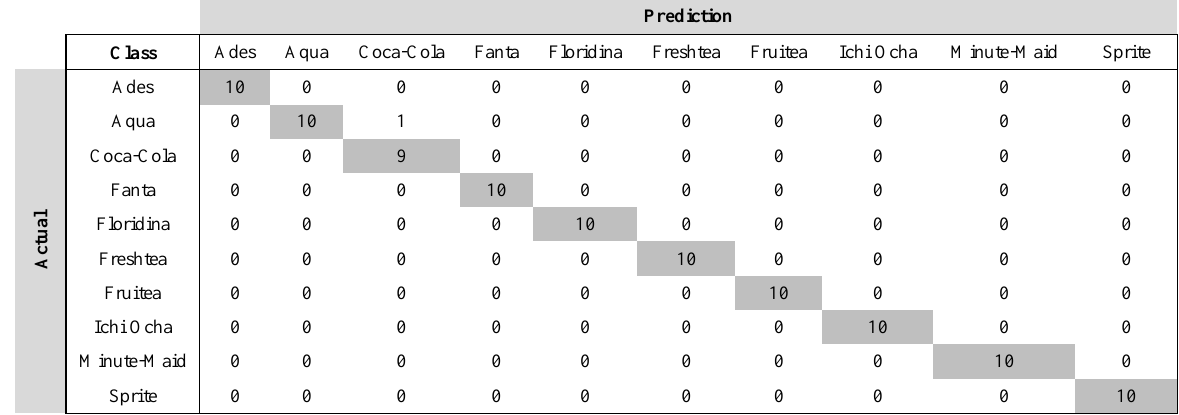
Table 2. Result Confusion Matrix CNN